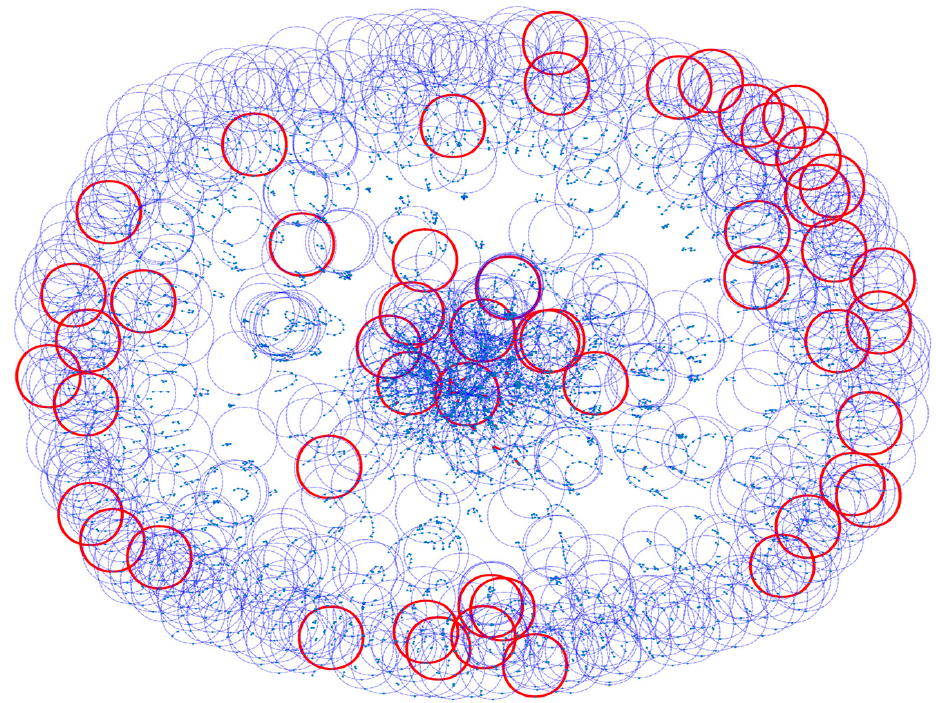
Figure 4. Visualization of the roads for the first 10,000 consulted URLs. Each node (blue points) corresponds to a URL (a web page associated with a paper) for sessions in which multiple pages were viewed. An edge connects two nodes when the user has successively consulted the corresponding pages. Edges are represented either with blue lines (low frequency) or red lines (high frequency).